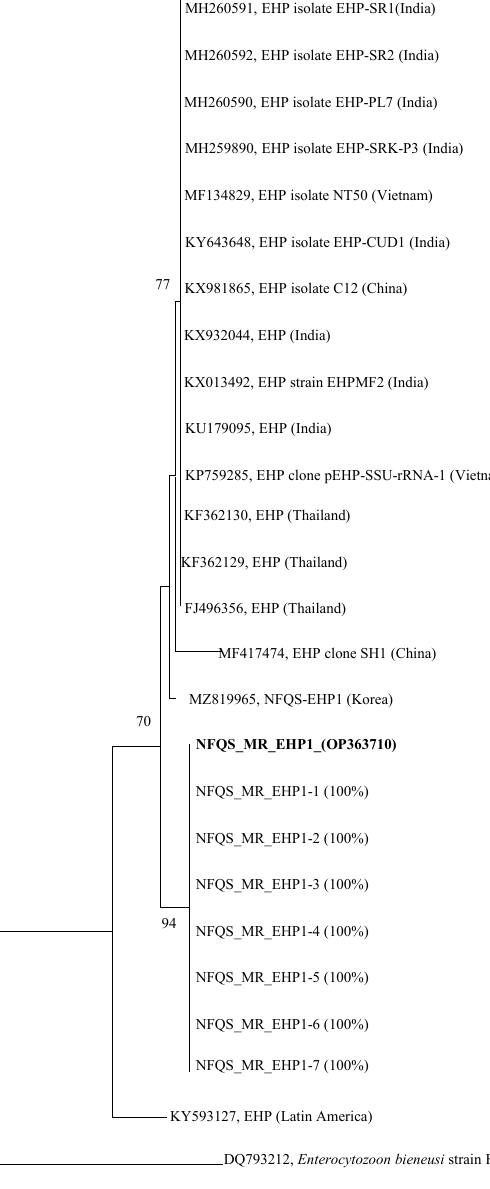
Figure 1. The phylogenetic tree was constructed by the neighbor-joining method, using MEGA software (version X; http://www.megasoftware.net (accessed on 5 October 2022)). All reference sequences were acquired from the GenBank database (http://www.ncbi.nlm.nih.gov/genbank (accessed on 5 October 2022)). Enterocytozoon bieneusi (DQ793212) was used as the outgroup. Only bootstrap values above 70% are shown (1000 resamplings) at branch points. Bar, 0.01 substitutions per site. Bold refers to a strain separated from giant freshwater prawn in Korea.